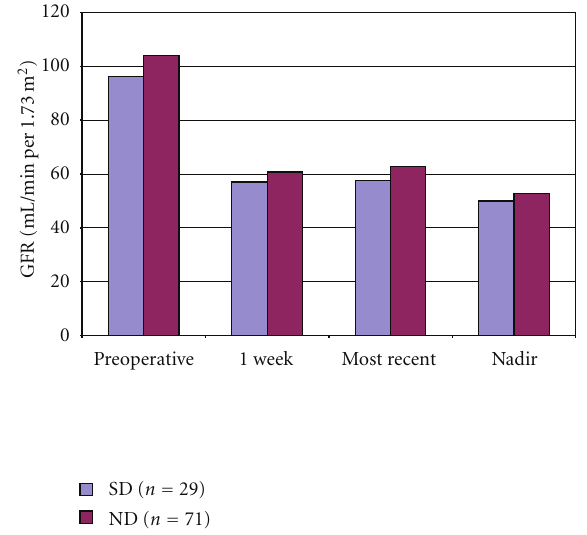
Figure 5: Comparison of calculated glomerular filtration rates in mL/min per 1.73 m 2 between living kidney donors with a history of tobacco use (SD) and those with no history of tobacco use